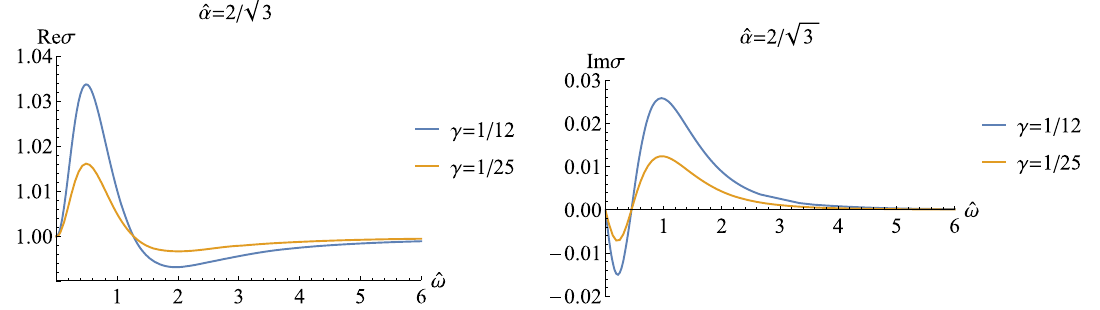
Fig. 6 The real part (left plot) and the imaginary part (right plot) of the optical conductivity as the function of ˆ ω for ˆ α = 2 / of γ . (For interpretation of the references to color in this figure, the reader is referred to the web version of this paper)